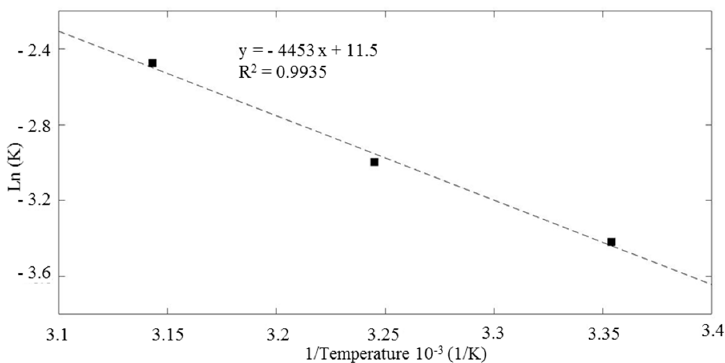
Figure 7. Arrhenius-type plot for the evaluation of the activation energy of the reaction.